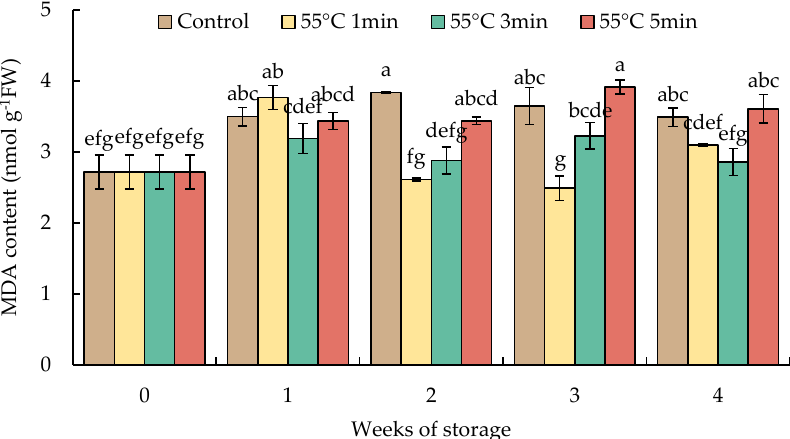
Figure 6. Effect of hot water treatment (55 ◦ C for 1, 3, 5 min) on malondialdehyde (MDA) content in red sweet pepper fruit during storage at 10 ◦ C. Data represent means ± S.E. (n = 3). Different letters on bars are significantly different ( p < 0.05).